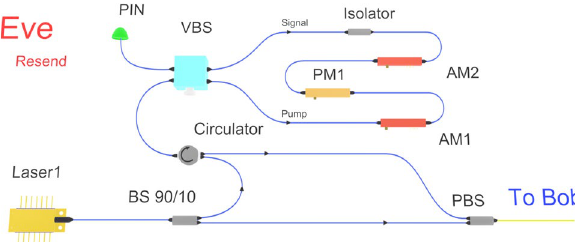
Figure 7. Experimental setup for generating displaced coherent state. AM: Amplitude Modulator, PM: Phase Modulator, BS: BeamSplitter. In the Sagnac loop, Gaussian modulated signals are prepared using the AM and PM modulators and are then displaced at the Variable Beam Splitter (VBS), based on a coherent interference between pump. Displaced signals is then sent to Bob along with local oscillator.